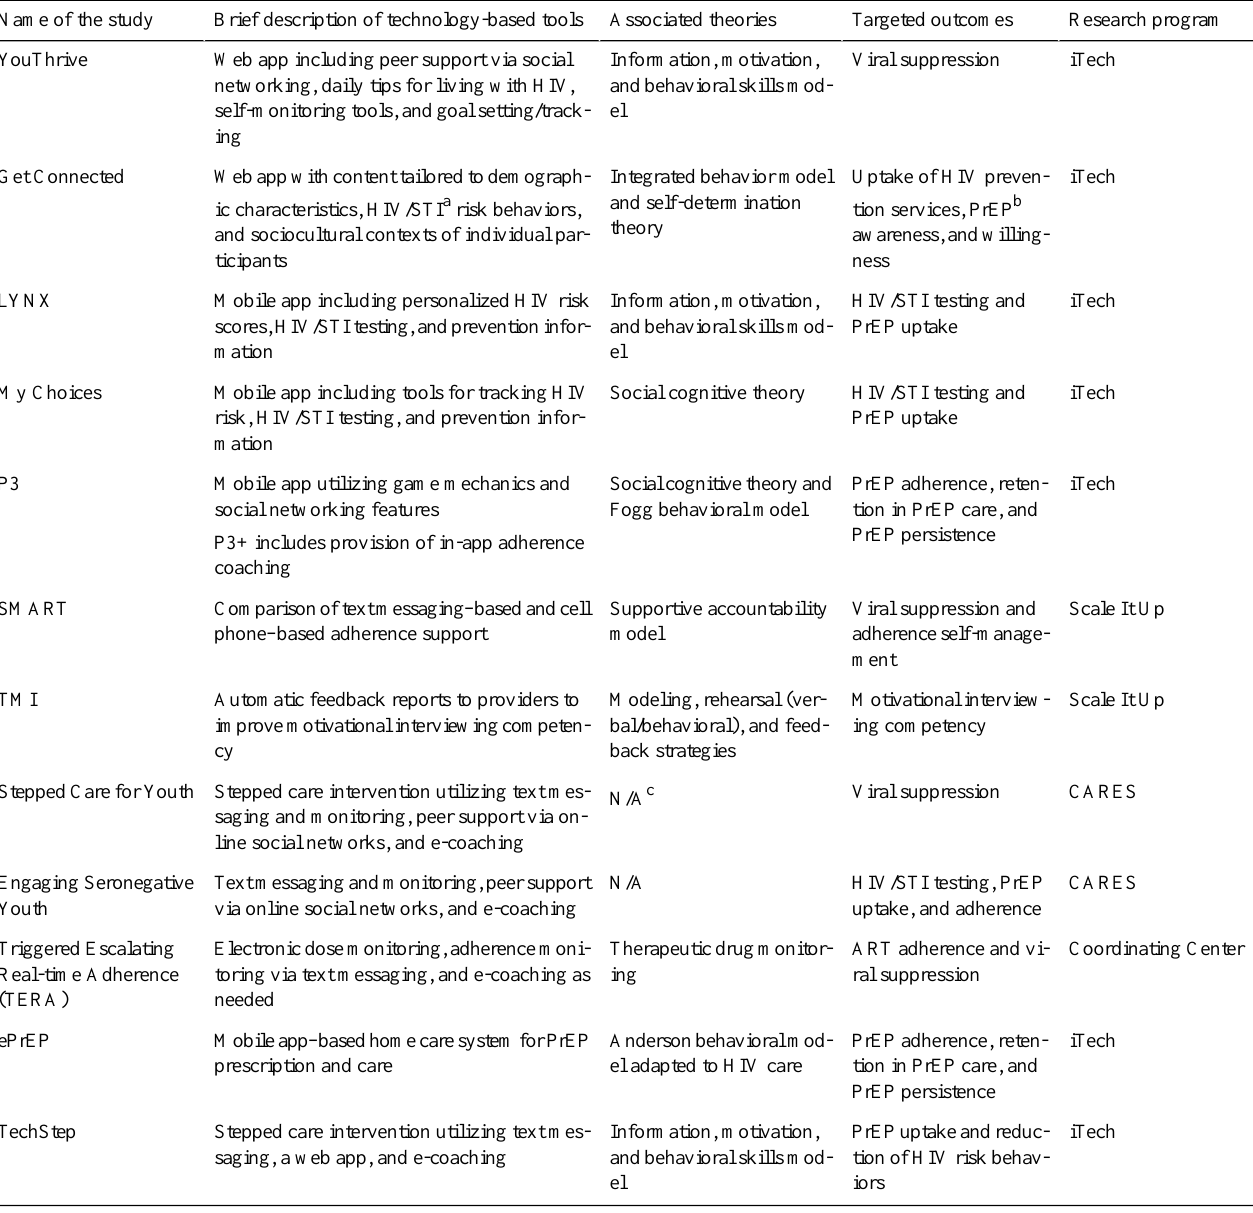
Table 1. Technology-based tools utilized in ATN